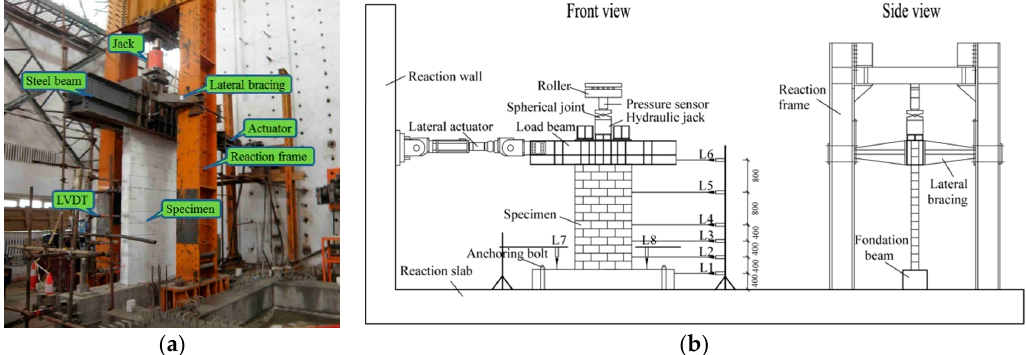
Figure 4. Test setup and instrumentation for cyclic test: ( a ) Test setup; and ( b ) schematic diagram.